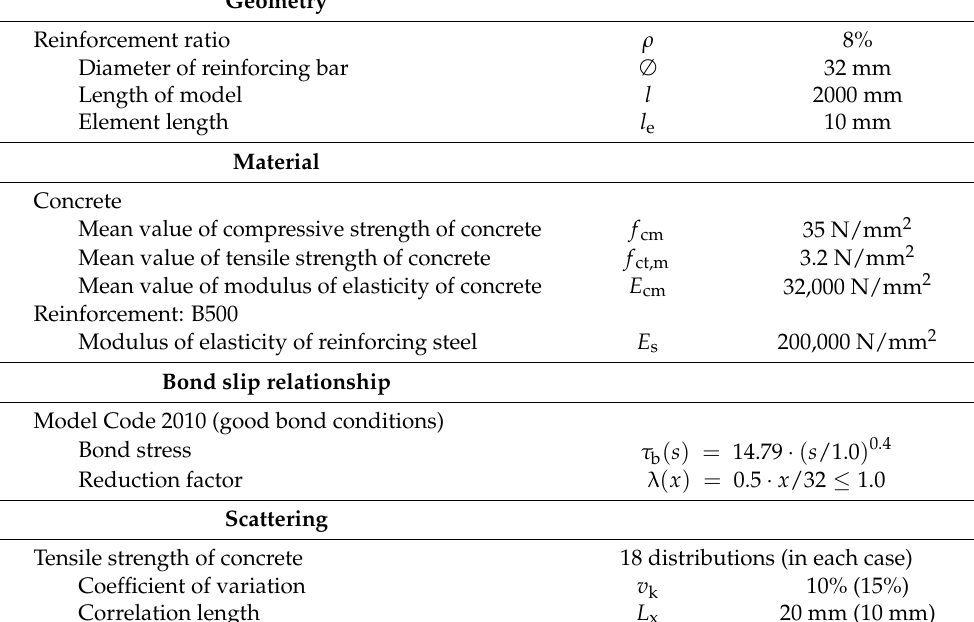
Table 3. CPM parameters for the test series conducted by Naotunna